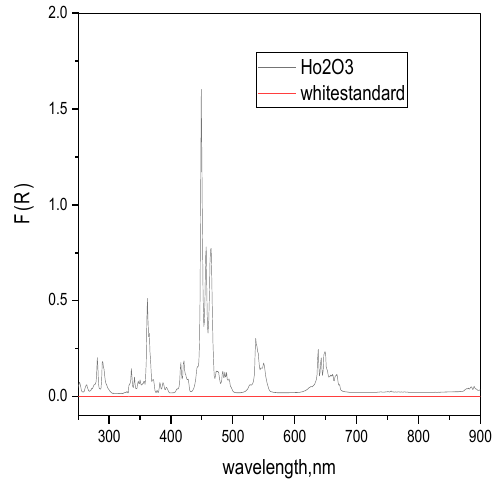
Figure 13. Diffuse reflectance spectra of Ho 2 O 3 powders, together with the baseline used here / white certified reflectance standard.